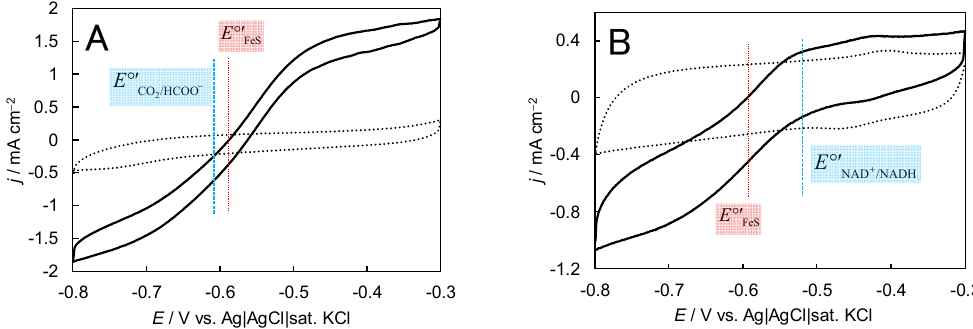
Figure 12. ( A ) Cyclic voltammograms (CVs) for HCOO − oxidation and CO 2 reduction at FoDH-modified mesoporous carbon electrodes constructed with 4-mercaptopyridine-modified gold nanoparticles in 1.0 M phosphate buffer (pH 6.6) containing 10 mM HCOONa under CO 2 gas- saturated and quiescent conditions at 25 °C and v = 10 mV s − 1 . The dotted lines represent CVs in the (cid:4593) (the blue line) and E °′ absence of the substrate. 𝐸° (cid:2887)(cid:2899) FeS (the red line) are the formal potentials (cid:3118) /(cid:2892)(cid:2887)(cid:2899)(cid:2899) (cid:3127)